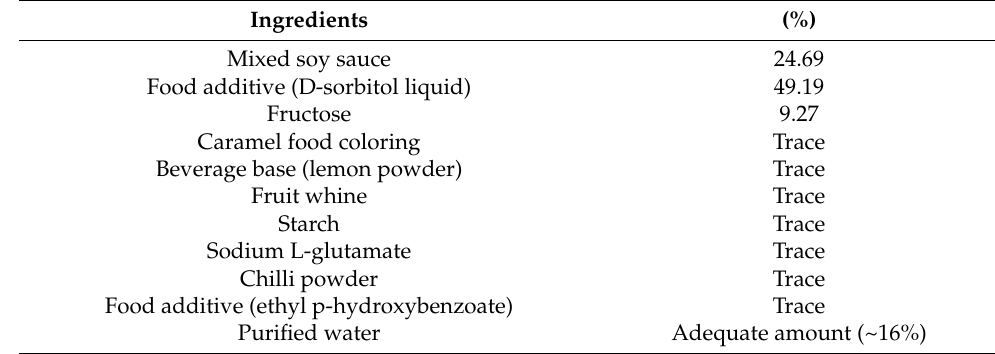
Table 1. Ingredients used to prepare the sauce (stock), a key ingredient of the new home meal replacement (HMR)